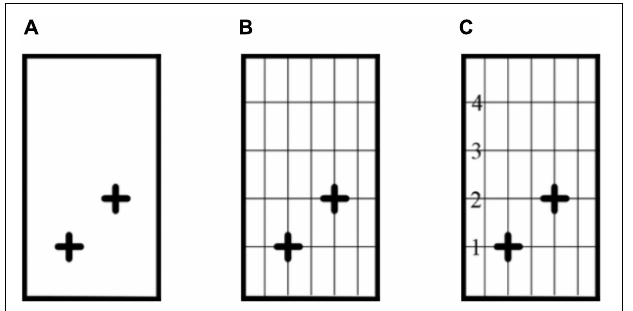
FIGURE 3 | Symbolic artifacts overlaid onto the Mathematics Imagery Trainer activity space: (A) the two cursors; (B) a grid; (C)